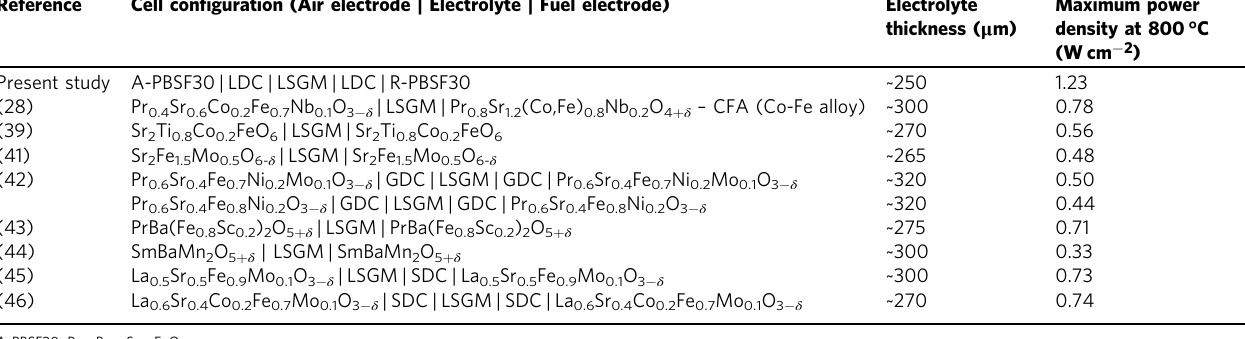
Table 1 Comparison of the electrochemical performance of La 1- x Sr x Ga 1- y Mg y O 3 − δ (LSGM) electrolyte-supported symmetrical solid oxide fuel cells (S-SOFCs) reported in the literature and in the present study. Reference Cell con fi guration (Air electrode | Electrolyte | Fuel electrode)